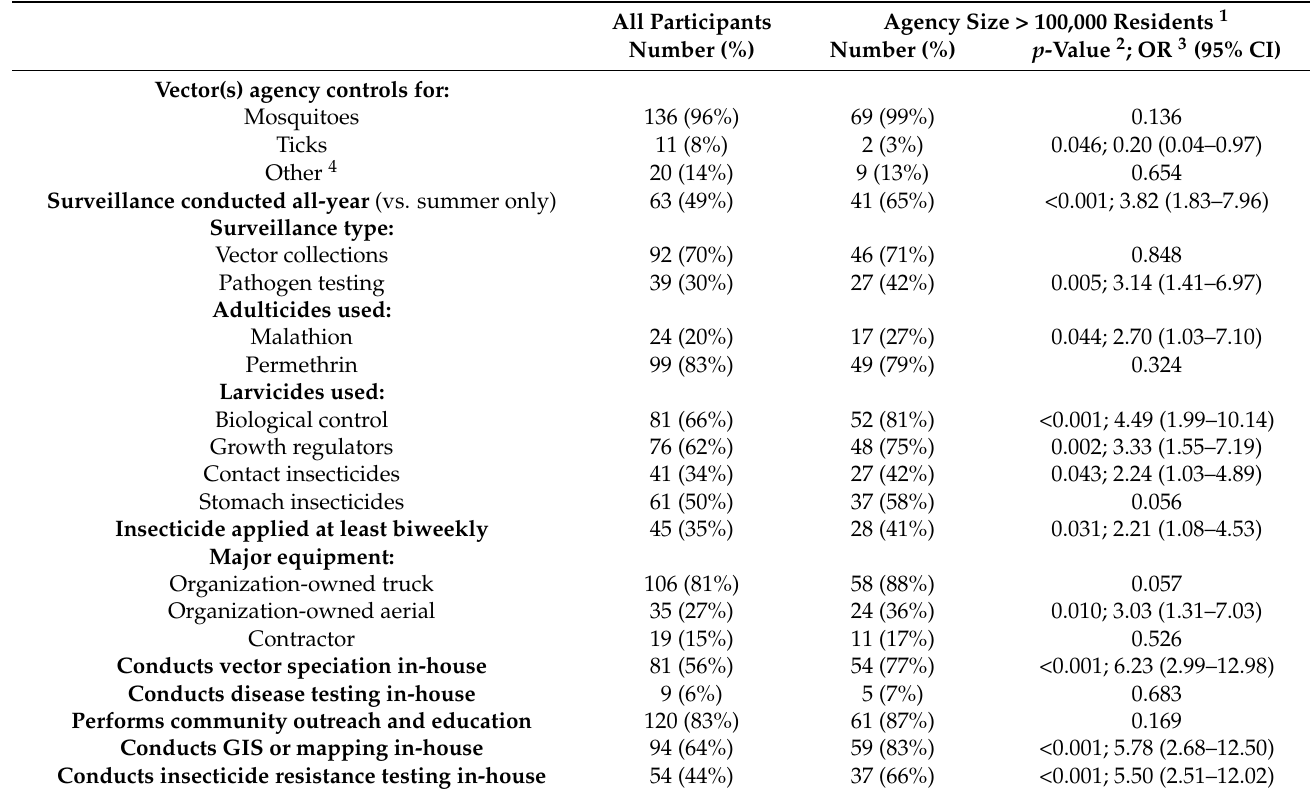
Table 1. Organizational capacity stratified by service area population size.